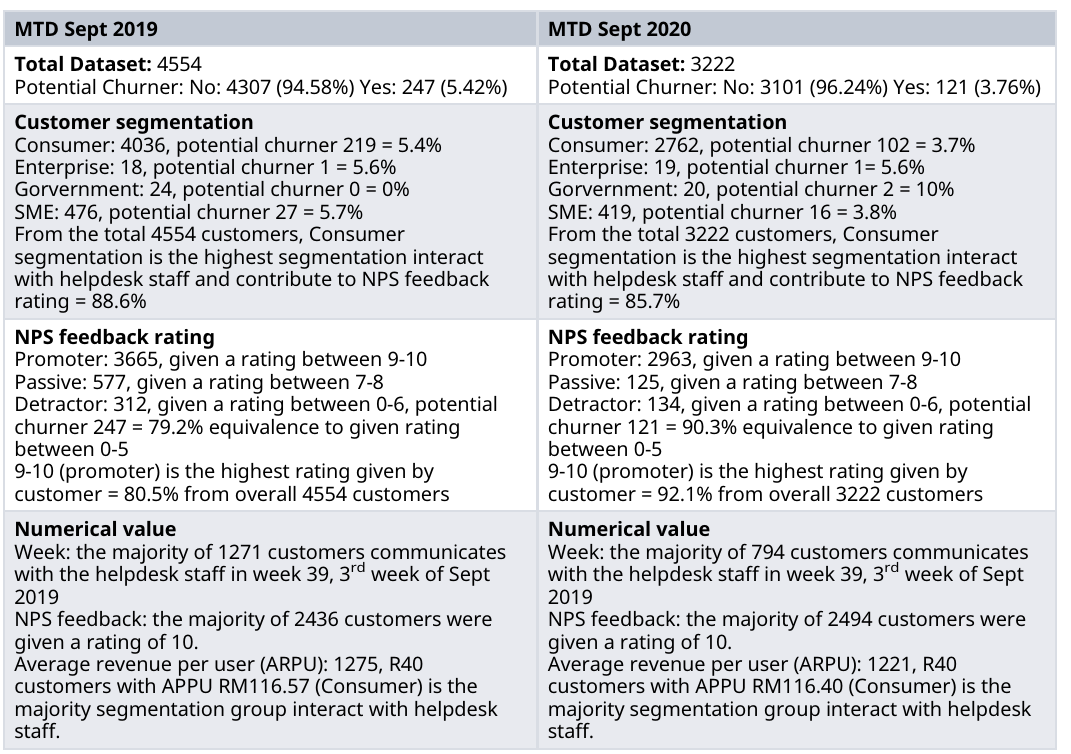
Table 11. Key findings from the discovery